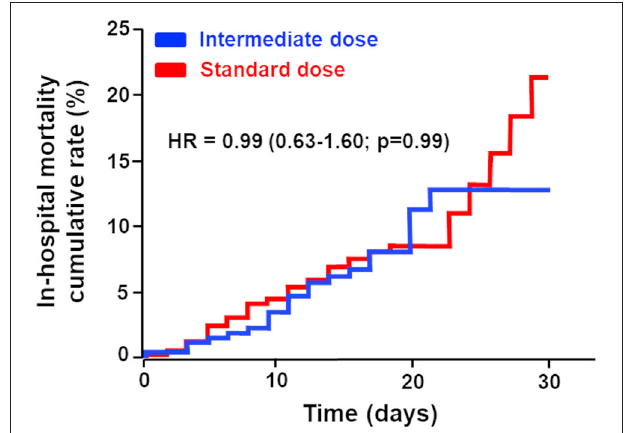
FIGURE 1 | Cumulative in-hospital mortality rate of patients with COVID-19 admitted to medical wards treated either by intermediate-dose vs. standard-dose prophylactic. The primary outcome was in-hospital mortality. The median (interquartile range) follow-up time was 12 [8.0–19.0] days in the intermediate-dose group and 8 [5.0–12.6] days in the standard-dose prophylactic anticoagulation group.